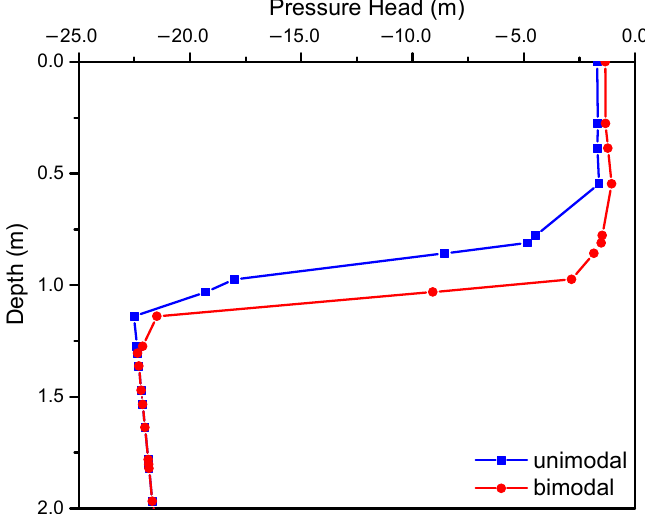
Figure 8. The changes in pressure head of the observation profile in unimodal and bimodal modes (at 48 h).